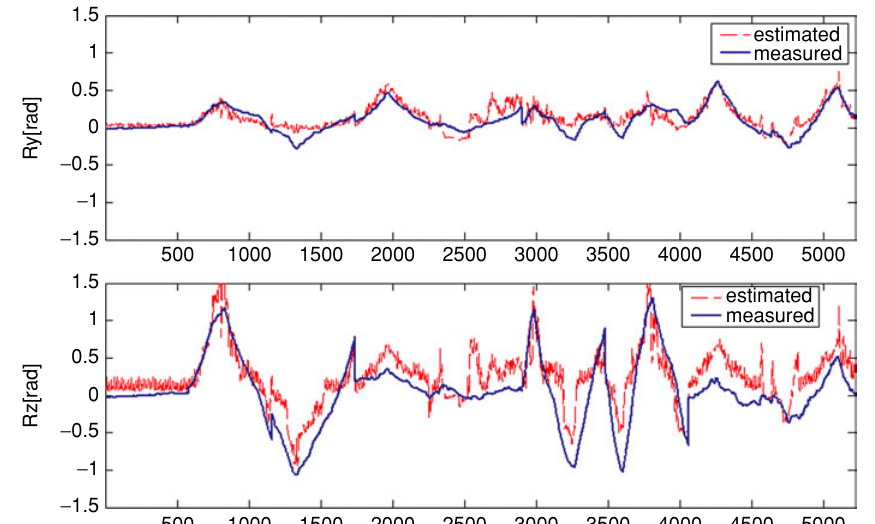
Figure 7 Estimation result for the shoulder